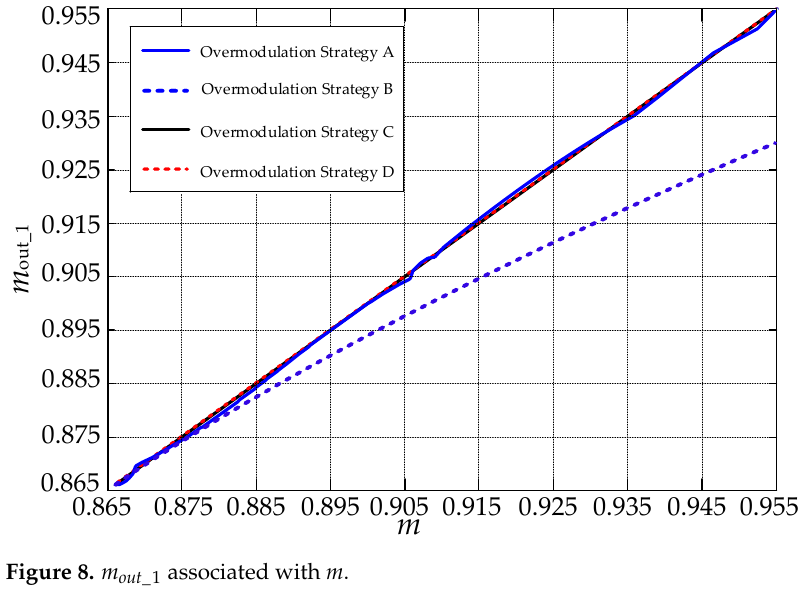
Figure 8. m out_ 1 associated with m .